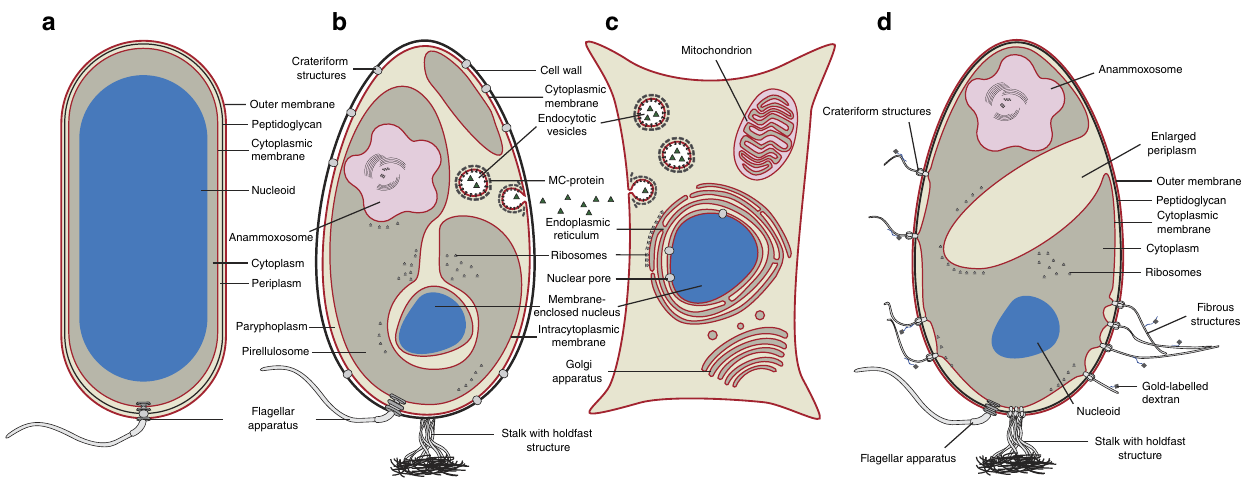
Figure 1 | Cellular structures of a typical bacterium, planctomycetes and eukaryotes. ( a ) A typical Gram-negative prokaryote is surrounded by an outer membrane (OM), a peptidoglycan (PG) cell wall and the cytoplasmic membrane (CM). The DNA forms the nucleoid and occupies a major portion of the cytoplasm. ( b ) Planctomycetes have been previously proposed to possess a unique cell plan. It was thought that PG was absent and replaced by a proteinaceous cell wall instead. The outermost membrane (OM) has been interpreted as CM, while an additional intracytoplasmic membrane (ICM) would divide the cytoplasm into a paryphoplasm and a pirellulosome. While the nucleoid of all Planctomycetes is highly condensed, G. obscuriglobus was proposed to contain an additional double membrane surrounding the DNA, similarly to the eukaryotic nucleus. Other planctomycetal species, the anammox bacteria, have additional subcellular structures such as the anammoxosome, an organelle responsible for the generation of energy. Most strikingly, Planctomycetes were reported to perform endocytosis-like uptake of macromolecules employing membrane-coat-like proteins that structurally resemble eukaryotic membrane-coat proteins such as clathrin. ( c ) A typical eukaryotic cell with membranous organelles and the ability to perform endocytosis. ( d ) Recent work and this study substantiate the view that Planctomycetes possess a Gram-negative cell architecture. The cells show a remarkable tendency for massive invaginations of the cytoplasmic membrane. Crateriform structures are found at sites of contact between the inner and outer membrane. Uptake of large molecules does not appear to be mediated by vesicles in P. limnophila and G. obscuriglobus